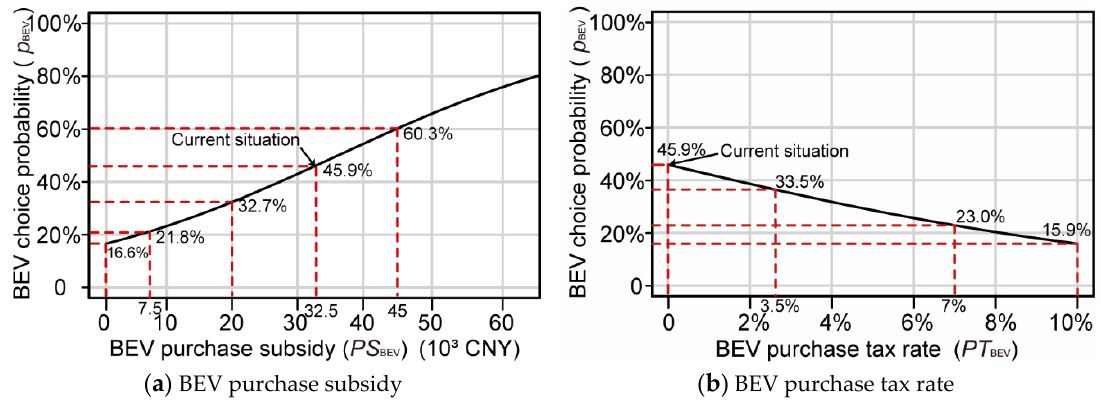
Figure 7. Sensitivity analysis of the BEV purchase subsidy and purchase tax rate.